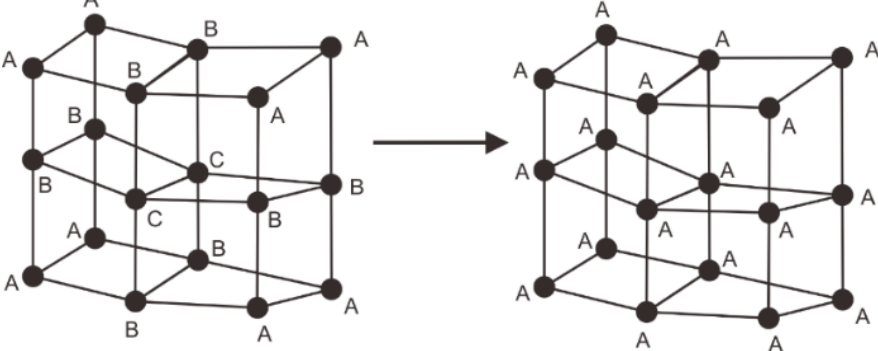
Figure 4. Node reconstruction involved in the 3D CP-to-FE grid transformation process.